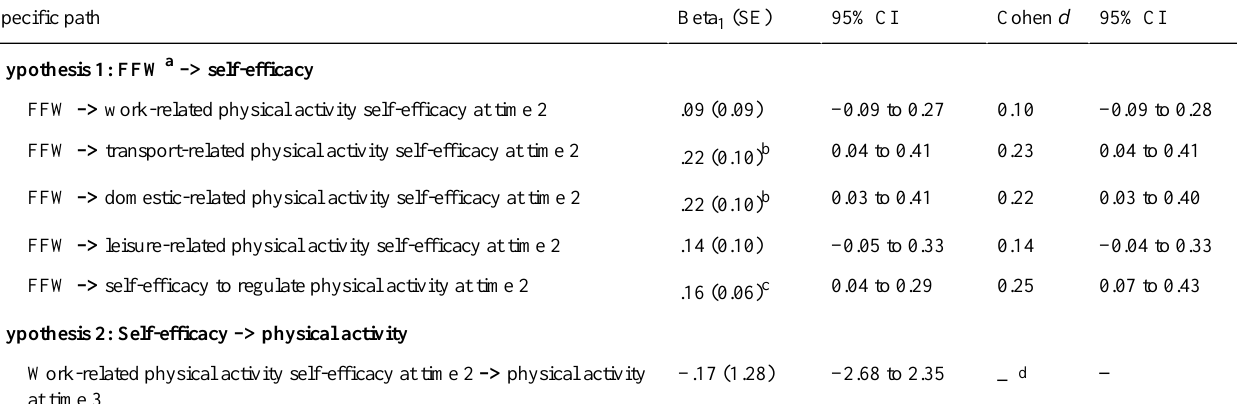
Table 3. Unstandardized estimate of each focal parameter from the path model by